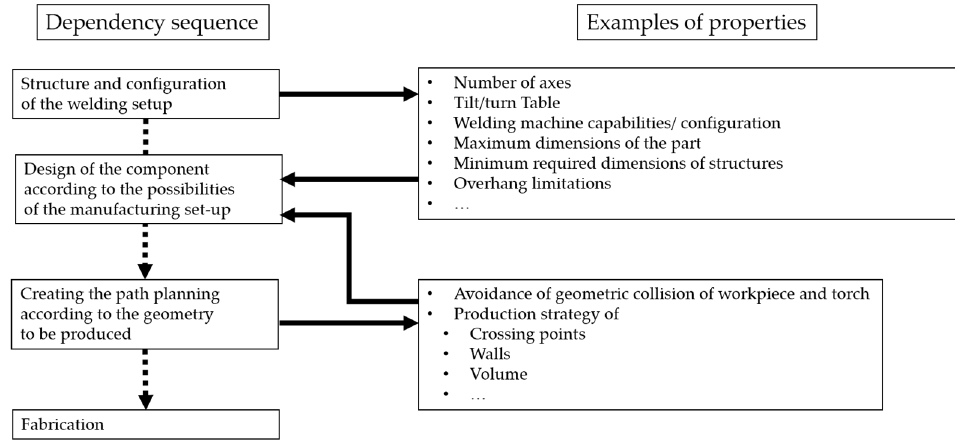
Figure 6. Dependencies between manufacturing setup, geometry generation and path planning.